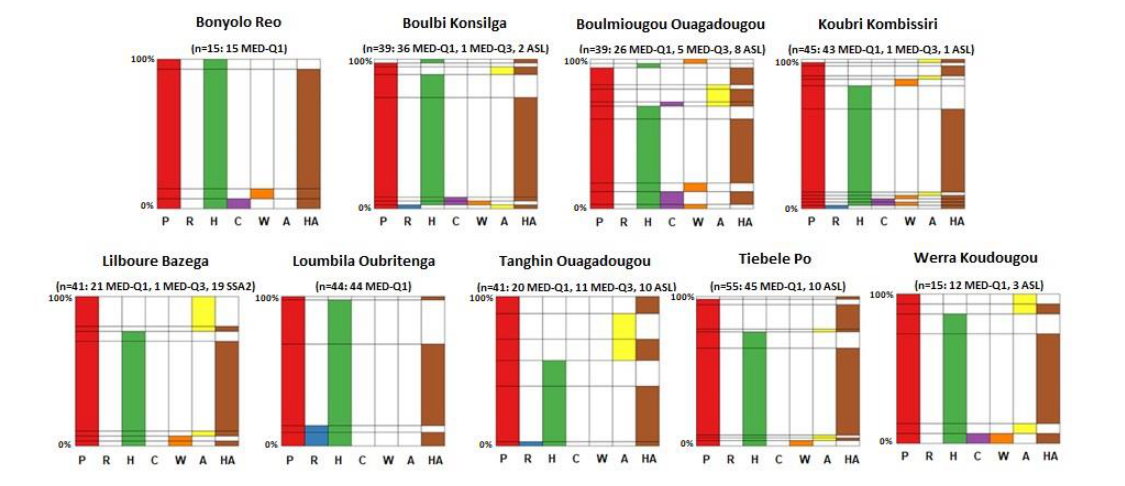
Figure S1. Infection status of Bemisia tabaci individuals collected in Burkina Faso according to the locality, determined through specific qPCRs. Each graph corresponds to one locality in Burkina Faso, with the different bacterial symbionts shown on the x-axis. Each bacterium is represented by a colour (red: Ca. Portiera aleyrodidarum (P), blue: Rickettsia (R), green: Hamiltonella (H), purple: Cardinium (C), orange: Wolbachia (W), yellow: Arsenophonus (A), brown: Ca. Hemipteriphilus asiaticus (HA)) and the corresponding coloured bar indicates its prevalence. On the y-axis host individuals are ranked and grouped together according to their infection status: when the graph is read horizontally, the colour combinations represent individuals sharing the same symbiotic community. n indicates the number of individuals checked. The number of individuals of each biotype is also